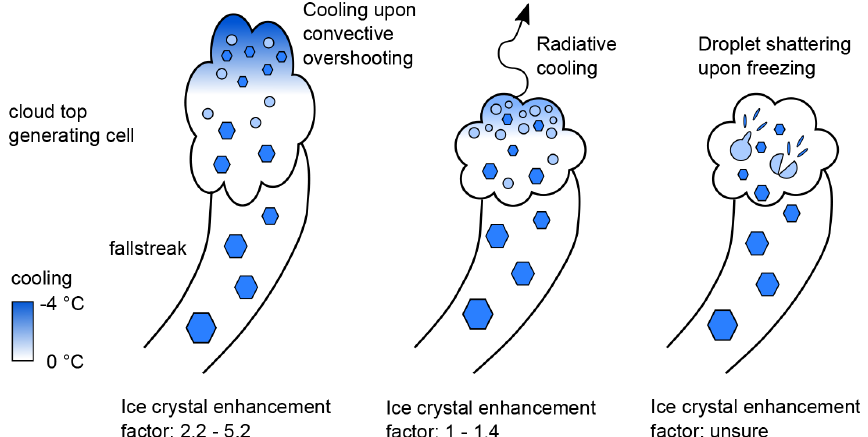
Figure 12. Potential mechanisms that could enhance the ICNC in cloud top generating cells: convective overshooting (left), radiative cooling (center) and droplet shattering upon freezing (right). Their ice crystal enhancement factors for the present case study are estimated at the bottom and further discussed in Appendix